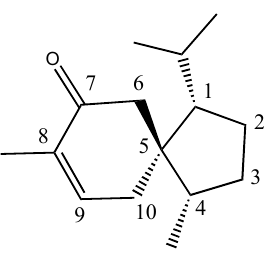
Figure 2. Chemical structure of acorenone B.